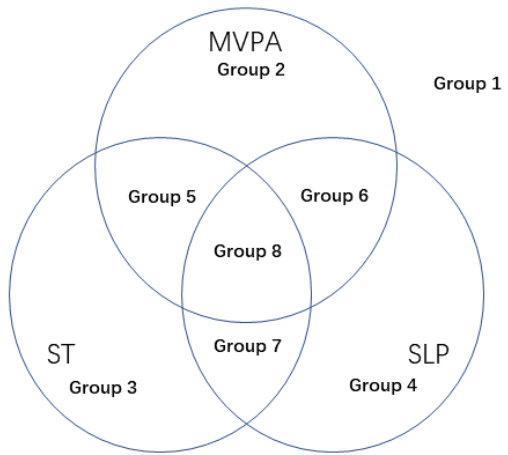
Figure 2. The eight groups for three health-related behaviors. Notes: Group 1 represents preschool children who did not meet the three health-related behaviors; Group 2 represents preschool children who only met the MVPA guideline; Group 3 represents preschool children who only met the ST guideline; Group 4 represents preschool children who only met the SLP guideline; Group 5 represents preschool children who met the MVPA and ST guidelines; Group 6 represents preschool children who met the MVPA and SLP guidelines; Group 7 represents that preschool children who met the ST and SLP guidelines; and Group 8 represents preschool children who met all three health-related behaviors ’ guidelines.